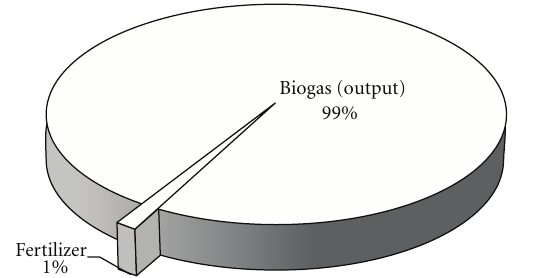
Figure 4: Emergy output ratio of BPC.